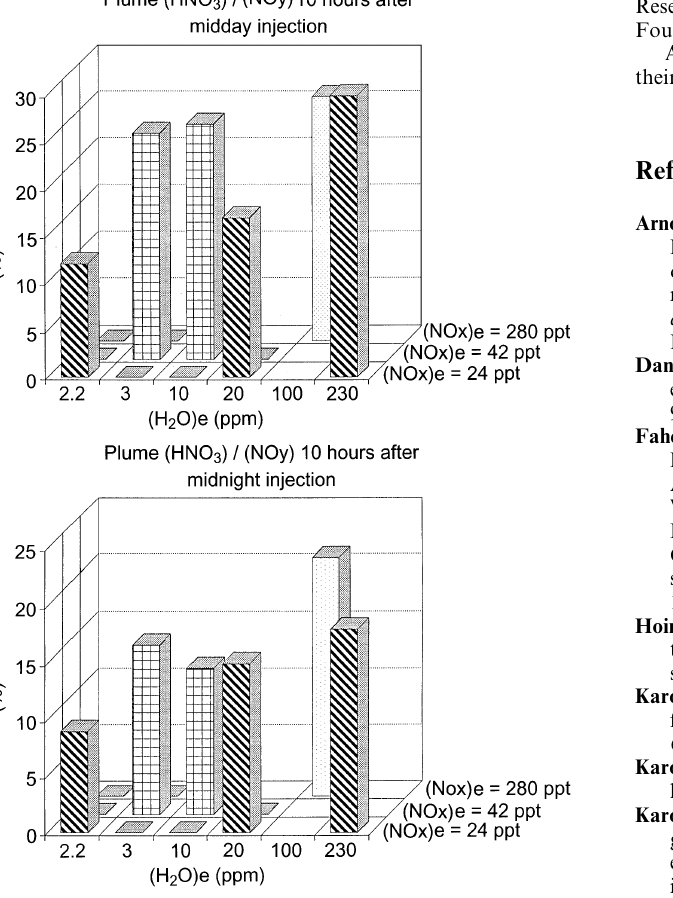
Fig. 12a, b. Same as in Fig. 11 but for (HNO (cid:51) )/(NO (cid:121)